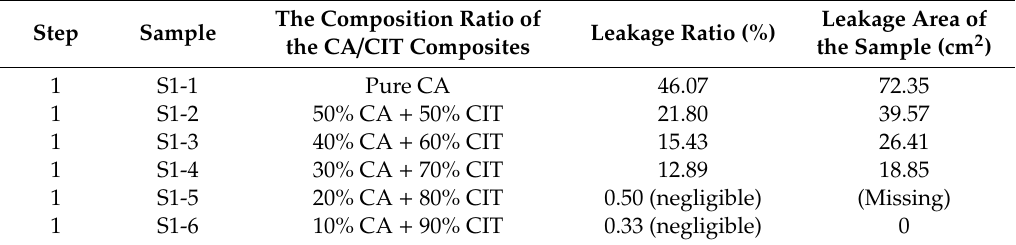
Table 3. Basic proportion and leakage results of CA/CIT composites.